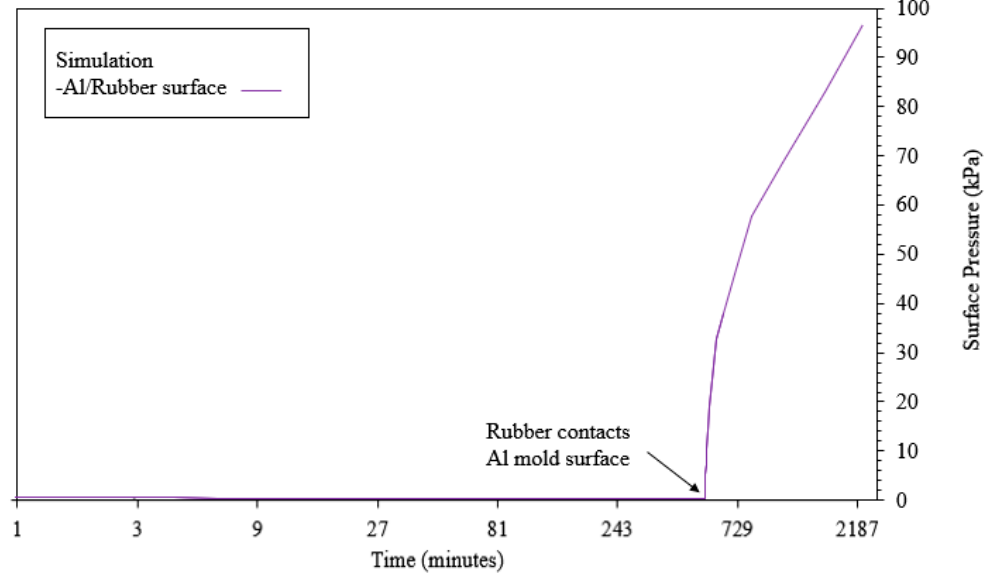
Figure 7. Rubber Surface Pressure (kPa) over time.